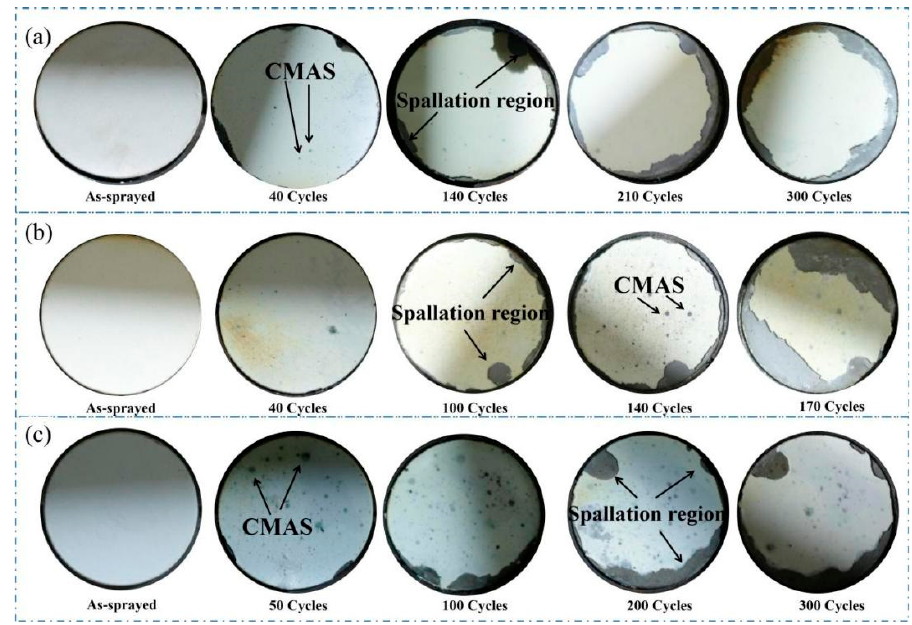
Figure 5. Macro-morphology of the surface of TBCs after thermal shock cycles: ( a ) specimen 1; ( b ) specimen 2; and ( c ) specimen 3.